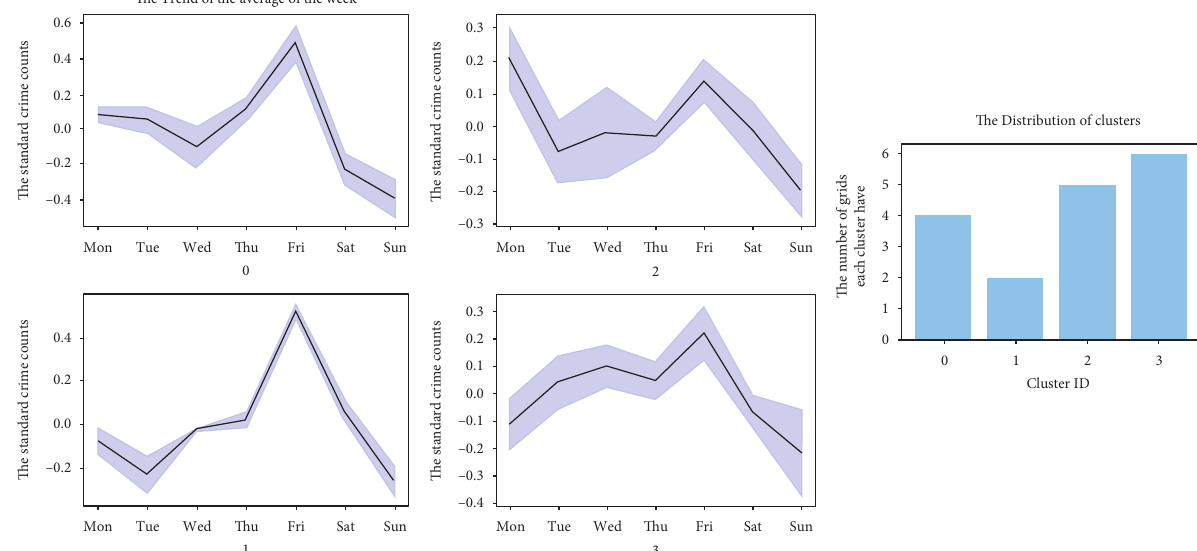
Figure 19: The burglary in New York trends in the average week in 2018 and the distribution of clusters. The line charts are the weekly trends of burglary in New York in 2018. The bar chart is the distribution of the clusters.